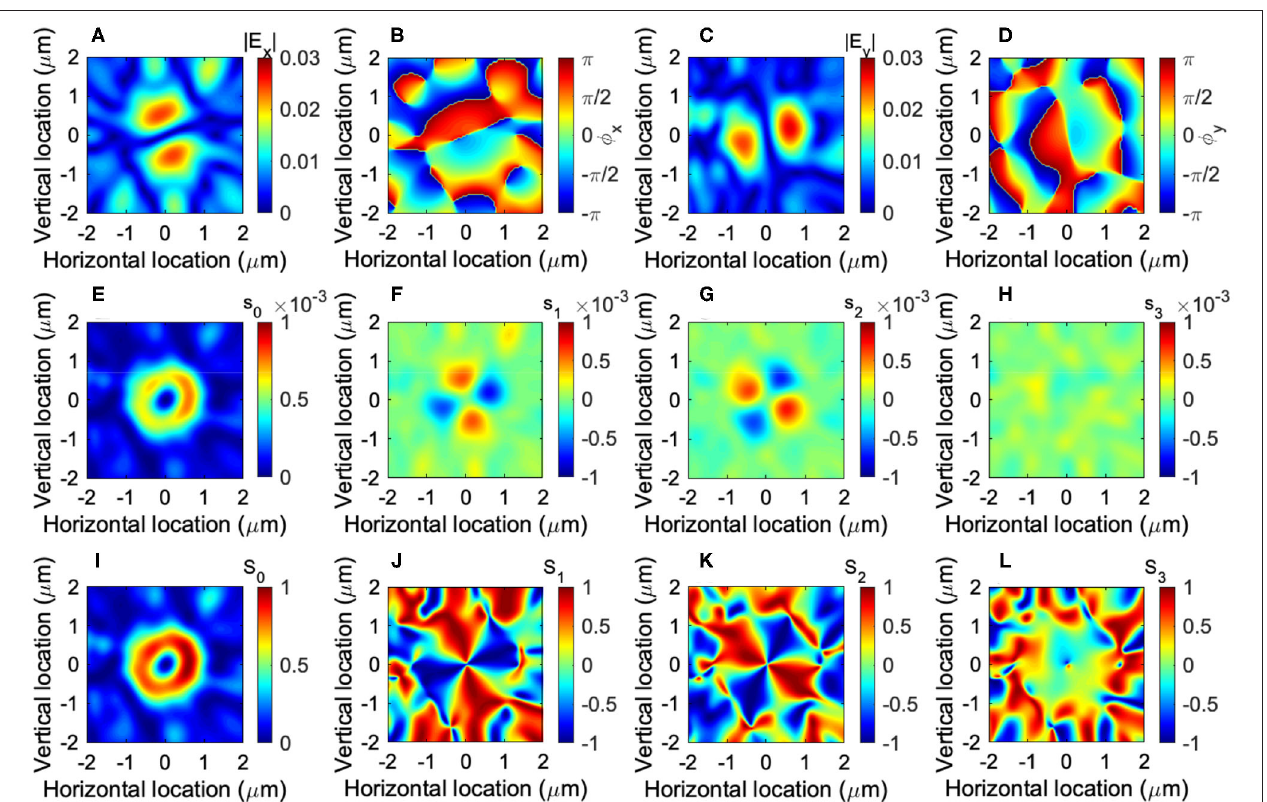
10. The input port 1 and 2 are used to inject photons to the waveguide, and the phase of the input = 1 µ m above the gear. (A) The amplitude ( =